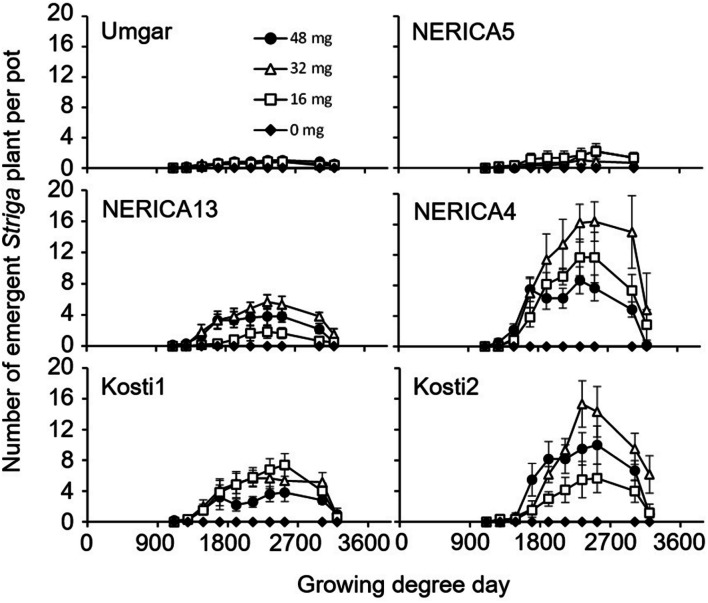
Number of emergent S. hermonthica plants per pots planted with rice. Umgar, NERICA5, NERICA13, NERICA4, Kosti1, and Kosti2 were used in the third pot experiment. The Striga seeds (0, 16, 32, and 48 mg) were mixed into top 5 cm of soil in each pot. Bars indicate standard errors of each mean value of six replications.